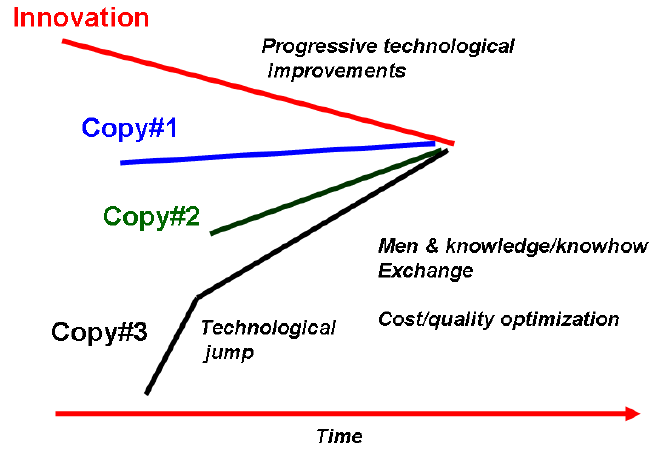
Figure 2. Evolution toward a common technology imposed by cost criteria and facilitated by the circulation of men and their